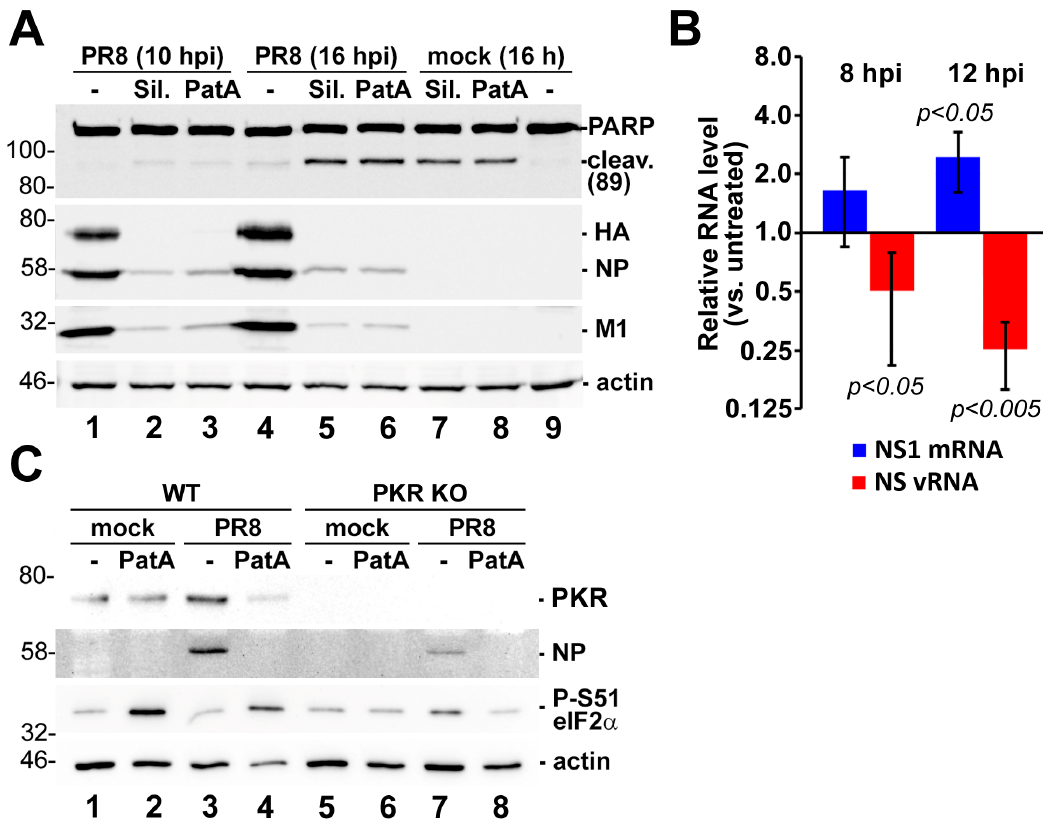
Figure 4. Sustained eIF4A inhibition by silvestrol and pateamine A leads to apoptosis. ( A ) Western blot analysis of A549 cell lysates obtained at the indicated times post-PR8-infection and treated with 320 nM silvestrol (Sil.) or 20 nM pateamine A (PatA) at 4 hpi or the equivalent time after mock infection. ( B ) Total RNA was isolated from cells treated with 320 nM silvestrol at 4 hpi and the relative levels of viral NS1 mRNA and vRNA at the indicated times post-infection were determined using RT-qPCR. Error bars represent standard deviations ( n = 3). p values were calculated using a paired Student’s t -test. ( C ) Western blotting analysis of 16 hpi lysates of A549 wild type (WT) or PKR knock-out (PKR KO) cells mock infected or infected with PR8 strain of IAV. Cells were treated with 320 nM silvestrol (Sil.) or 20 nM pateamine A (PatA) at 4 hpi or the equivalent time after mock